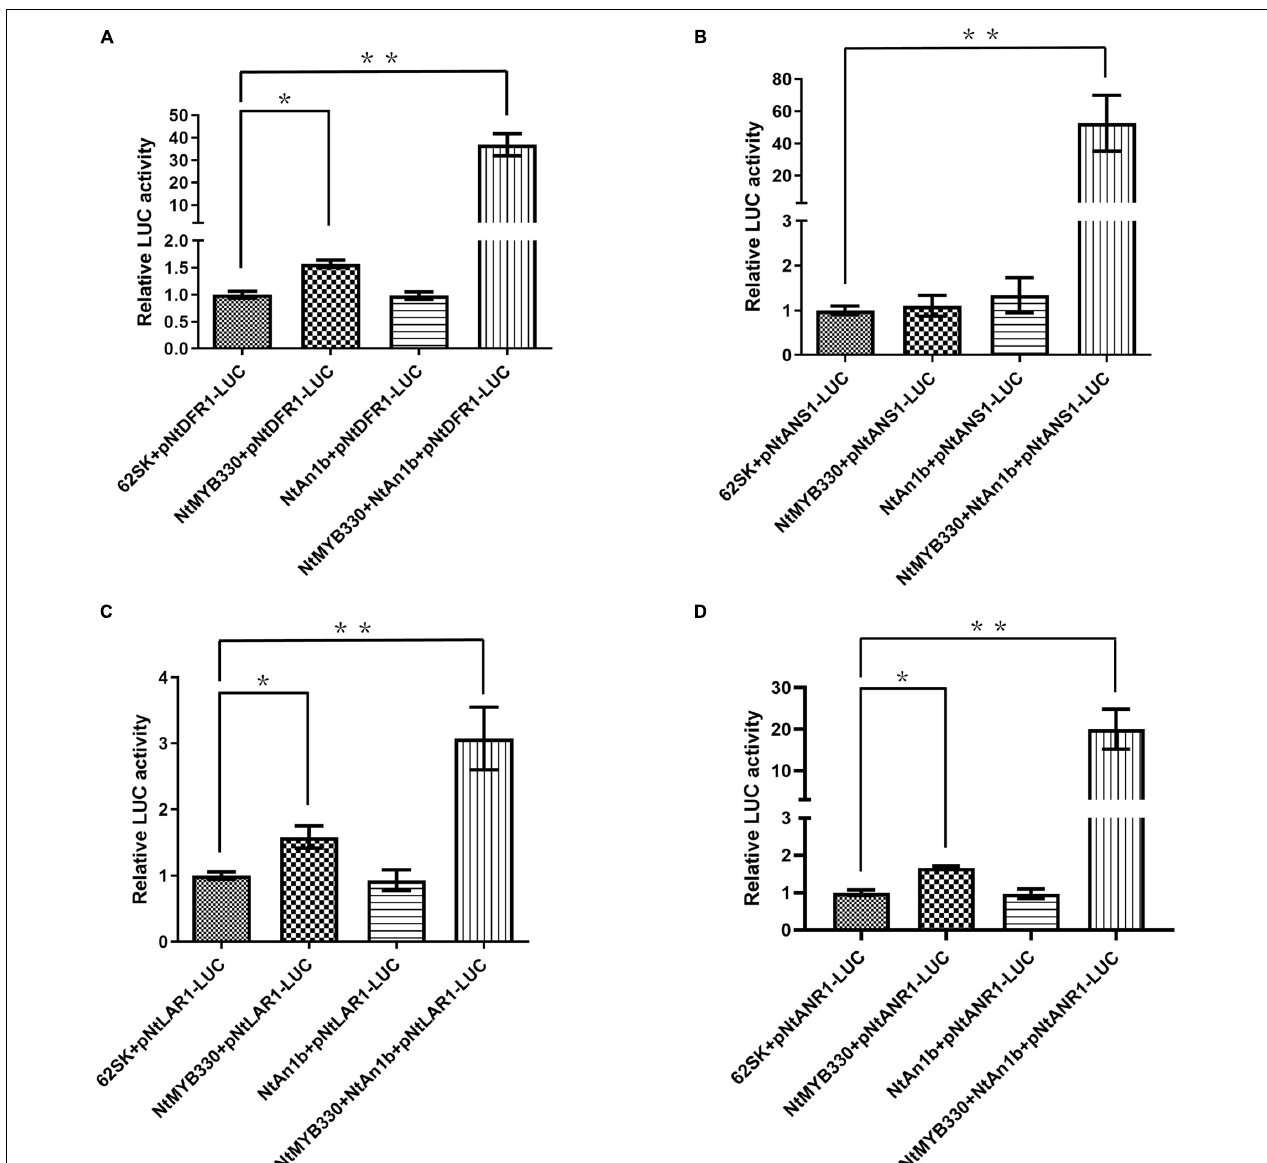
FIGURE 6 | Transactivation assays of NtMYB330 and NtAn1b in N. benthamiana leaves. The reporter plasmids contain a firefly luciferase gene driven by the promoters of (A) NtDFR1 , (B) NtANS1 , (C) NtLAR1 , or (D) NtANR1 . The effector plasmids contain the full-length cDNA of either NtMYB330 or NtAn1b , and were co-transformed, alone or in combination, with the reporter plasmid into the N. benthamiana leaf. A pGreenII 62-SK plasmid was used as the vector control (62SK). Results are presented as fold activation compared to the vector control. Error bars represent the mean ± SD of nine biological replicates. Asterisks indicate statistically significant differences from the vector control (* P < 0.05; ** P < 0.01) using one-way ANOVA followed by Bonferroni